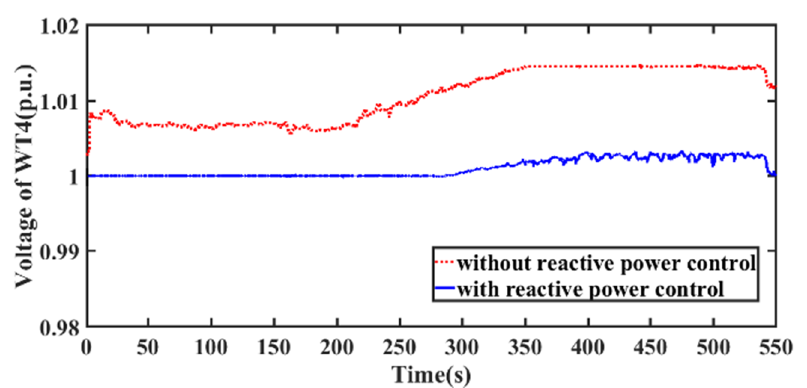
Figure 14. Voltage of WT4.